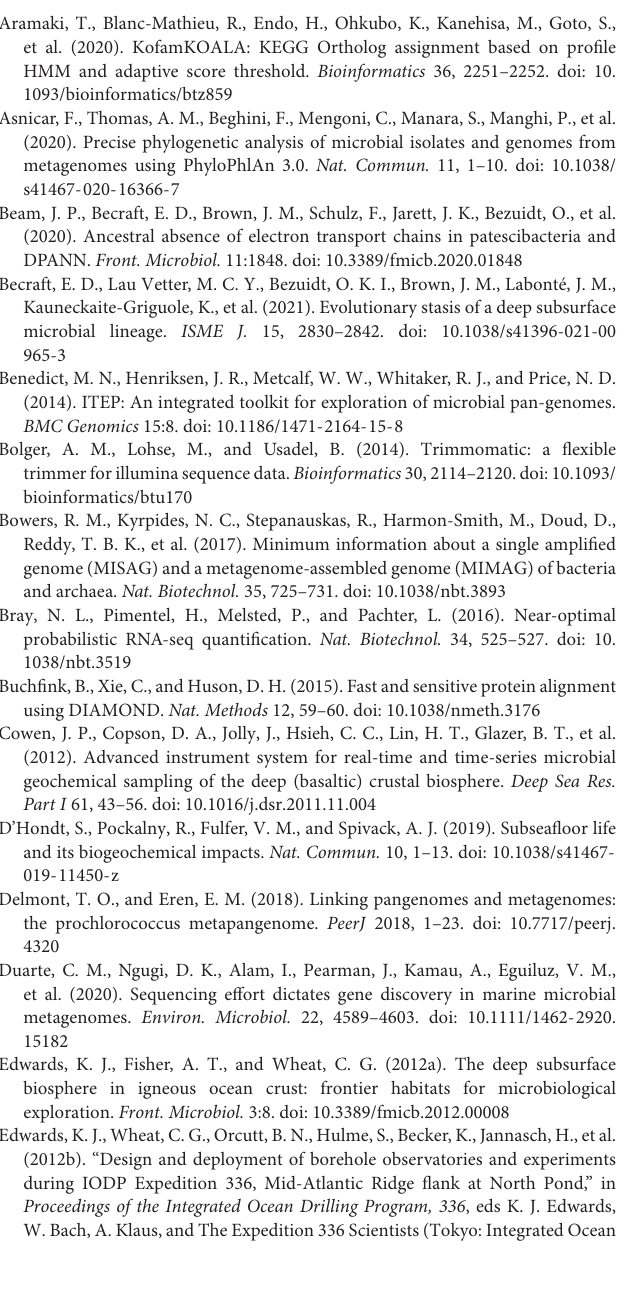
individual SAGs. Supplementary Data Sheet 6 | Gene cluster statistics resulting from Anvio Pangenomics